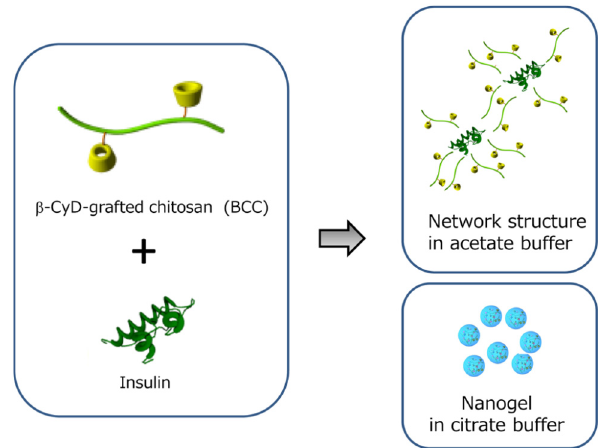
Figure 6. β -cyclodextrin-grafted chitosan based complexes able to suppress glucose levels. Reprinted with permission from Molecular Pharmaceutics 2016, 13, 12, 4034-4042. Copyright (2016) American Chemical Society. Molecules 2020 , 25 , x FOR PEER REVIEW